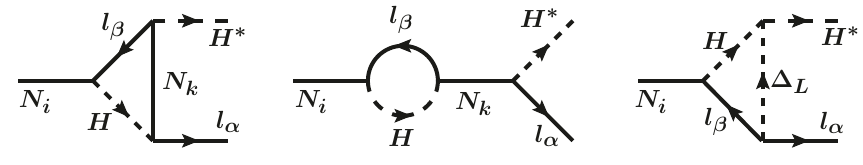
Figure 5 . Left handed triplet scalar one-loop